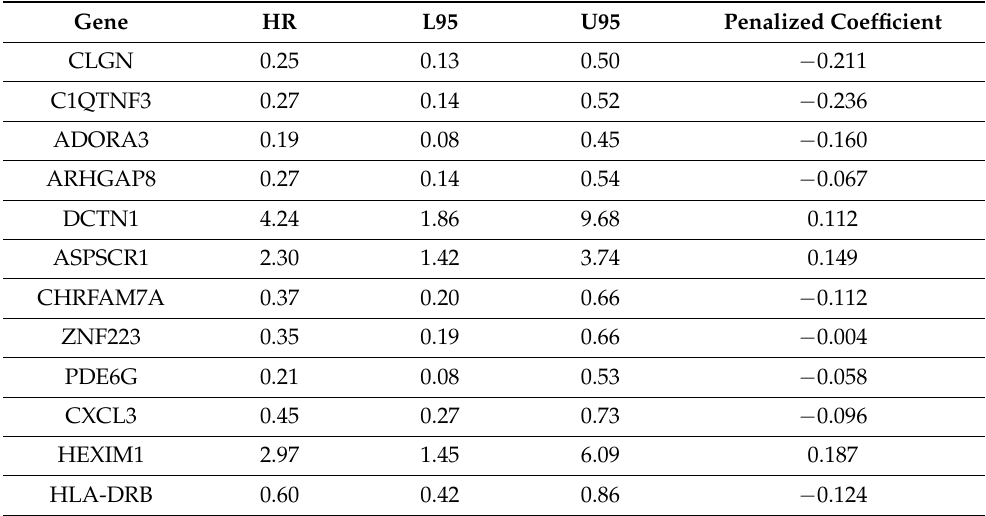
HR = hazard ratio; L95, (lower) U95 (upper) = 95% confidence bounds; Penalized Coefficient = penalized proportional hazards regression coefficient; A negative coefficient and a hazard ratio < 1 means that high gene expression lowers the risk of progression.